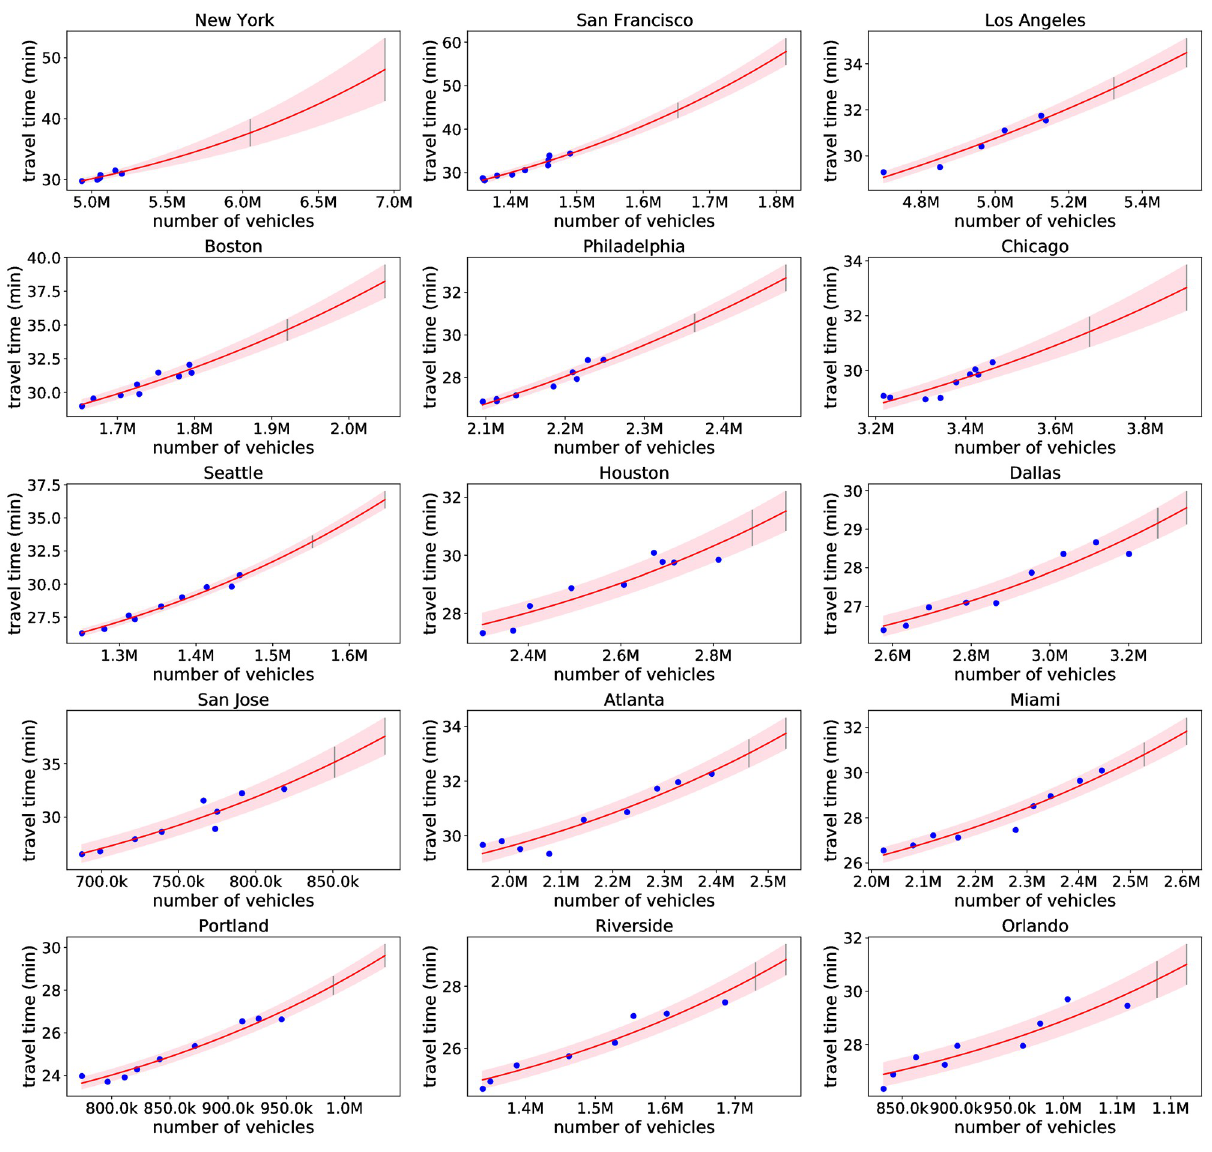
Fig 2. Bayes fit for 15 metro areas. The blue points are the observed data. The solid red line is the mean prediction, with shaded area covering ± one standard deviation of the prediction. Also shown are grey bars denoting the prediction intervals under a 25% (leftmost bar) and 50% (rightmost bar) transit and carpool mode shift to single occupancy vehicles. See also S1–S4 Figs for all 74 modeled metro